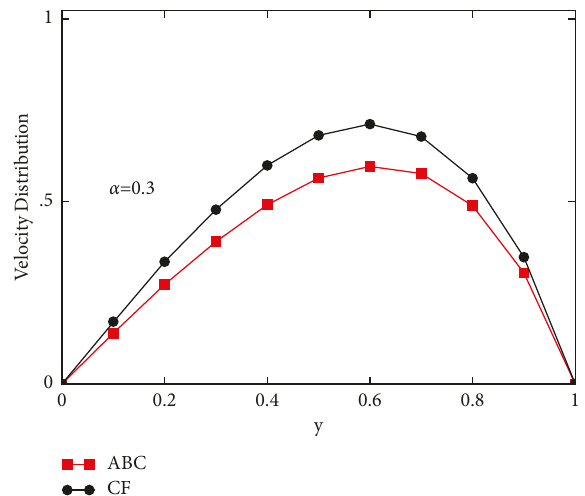
Figure 4: Correlation between the velocities through CF [37] and ABC, Pr 6 . 2, when t (cid:30) ϕ hnf 0 . 08. (cid:30)